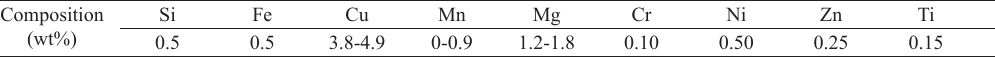
Table 1. Chemical composition of LY12 aluminium alloys. Composition (wt%)